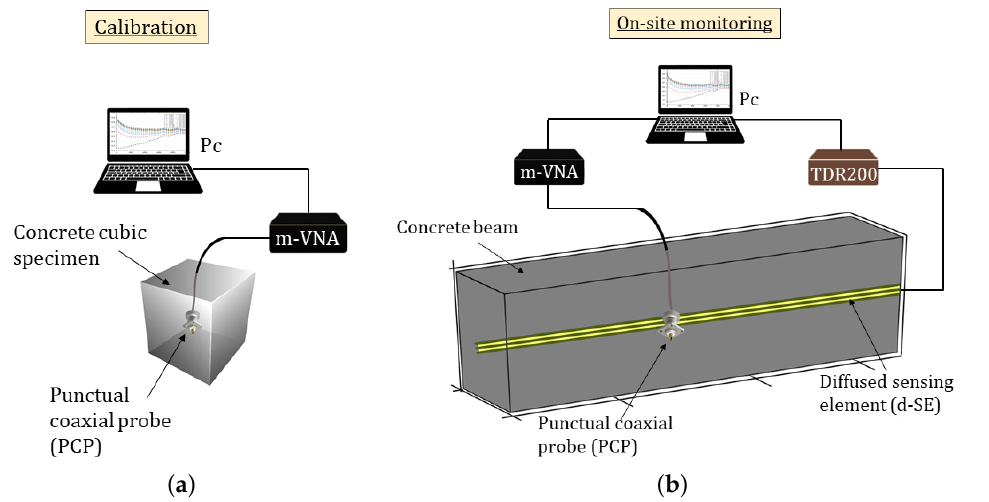
Figure 1. Sketch of the experimental measurement setup: ( a ) reference concrete specimen with an embedded PCP; ( b ) concrete beam with embedded a PCP and a d-SE.